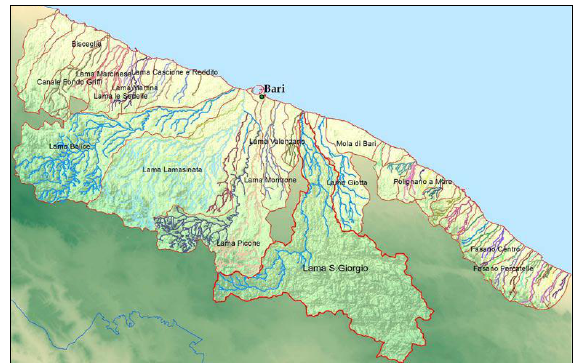
Figure 1. Location of the study area of Lama S. Giorgio in the province of Bari (Italy)